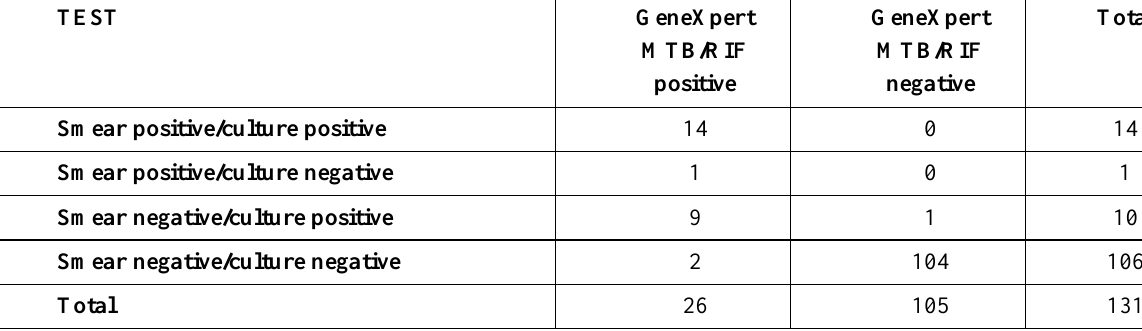
Table 3. Comparison between AFB smear microscopy/culture and GeneXpert among studied patients.